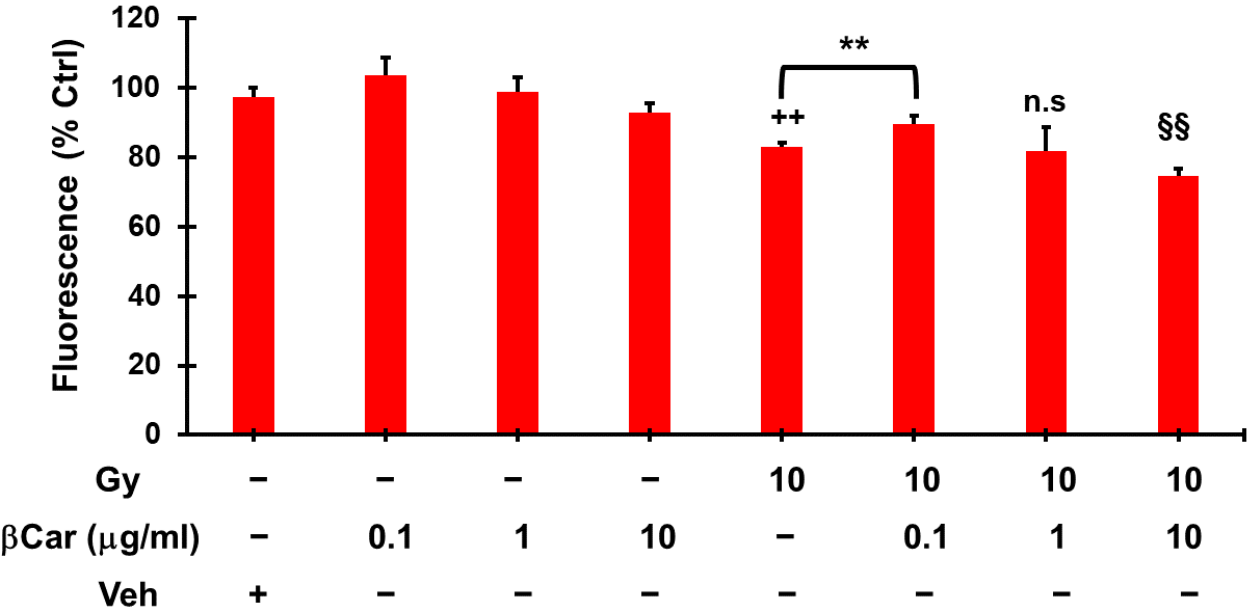
Figure 9. Cell death induced by CEN and radiation in SAOS400 is not dependent on β -carotene. SAOS400 cells were irradiated (10 Gy) and incubated for 144 h with β -carotene conveyed in cell culture medium by nanoemulsions with the indicated concentrations and respective combinations. Here, 1 μ g/mL is approximately the dose of β -carotene present in 200 μ g/mL of CEN. Cell viability was evaluated with the Cy-Quant fluorometric assay. The bar graphs represent the mean ± SD, and symbols and the linear bar indicate significance: ++ p < 0.01 10 Gy vs. Veh, ** p < 0.01 10 Gy vs. 0.1 μ g/mL β -carotene, 10 Gy vs. 1 μ g/mL β -carotene, n.s. not significant, §§ p < 0.01 10 Gy vs. 10 μ g/mL β -carotene, Student ’ s t test.